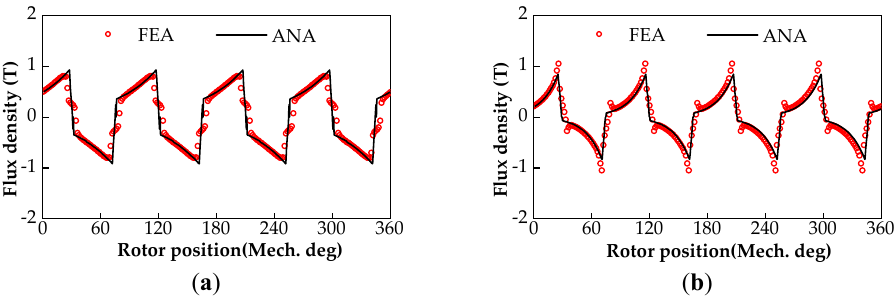
Figure 9. The on-load air-gap flux density of the PMECCs with non-slotted CR (Slip speed is 250 rpm): ( a ) Model − A; ( b ) Model − C.